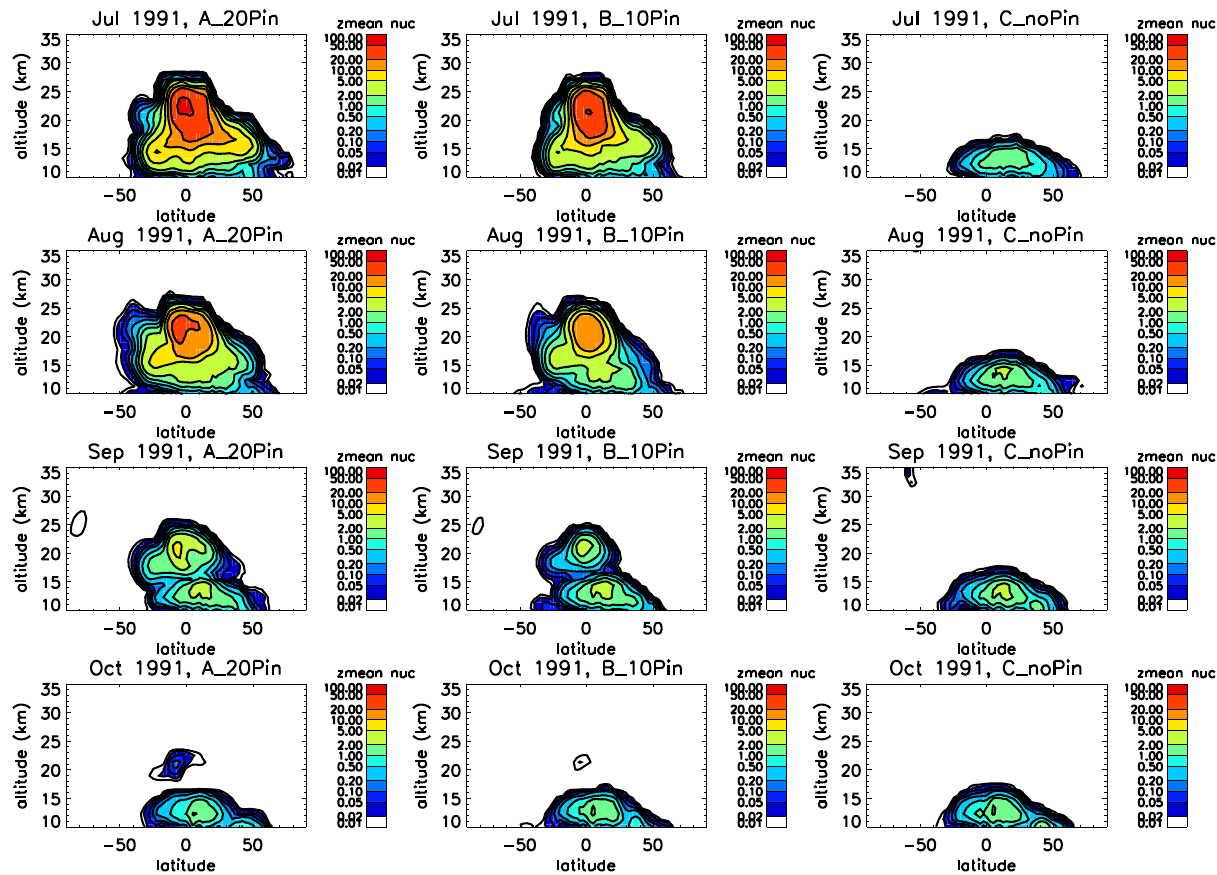
Figure 11. Modelled nucleation rates (cm 3 s − 1 ) from runs A_Control20 (left), B_Control10 (middle), and C_noPinatubo (right) for (top to bottom) July, August, September and October